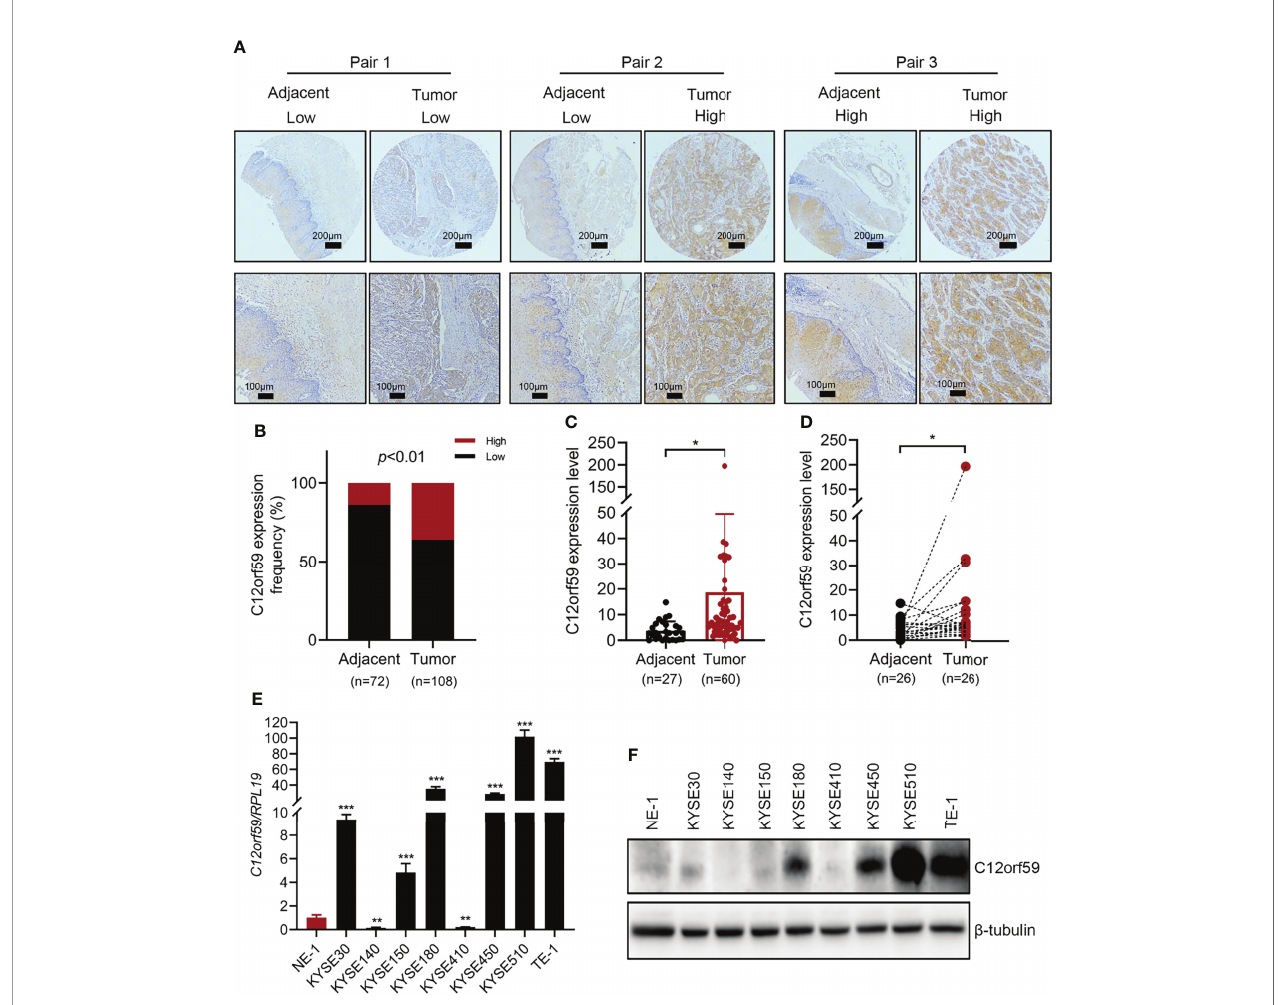
FIGURE 1 | The expression of C12orf59 is increased in ESCC tissues and cell lines. (A) Immunohistochemistry for C12orf59 in ESCC and adjacent normal tissues using a tissue microarray at low (upper panel; scale bar, 200 m m) and high magni fi cation (lower panel; scale bar, 100 m m). (B) Percentage of ESCC patients with high and low C12orf59 expression in ESCC tissues and adjacent normal tissues. (C) Real-time PCR analysis of C12orf59 in ESCC tissues and adjacent normal tissues. (D) C12orf59 mRNA levels in 26 paired ESCC tissues and adjacent normal tissues. (E) C12orf59 mRNA levels by real-time PCR in immortalized esophageal cell line NE-1 and ESCC cell lines. The relative C12orf59 mRNA levels in ESCC cell lines were normalized with NE-1 cell line. (F) C12orf59 protein levels by western blotting in immortalized esophageal cell line NE-1 and ESCC cell lines. RPL19 was used as the internal control for real-time PCR. b -tubulin was used as the loading control for western blotting. Data were presented as mean values with standard deviations, * p < 0.05; ** p < 0.01; *** p <